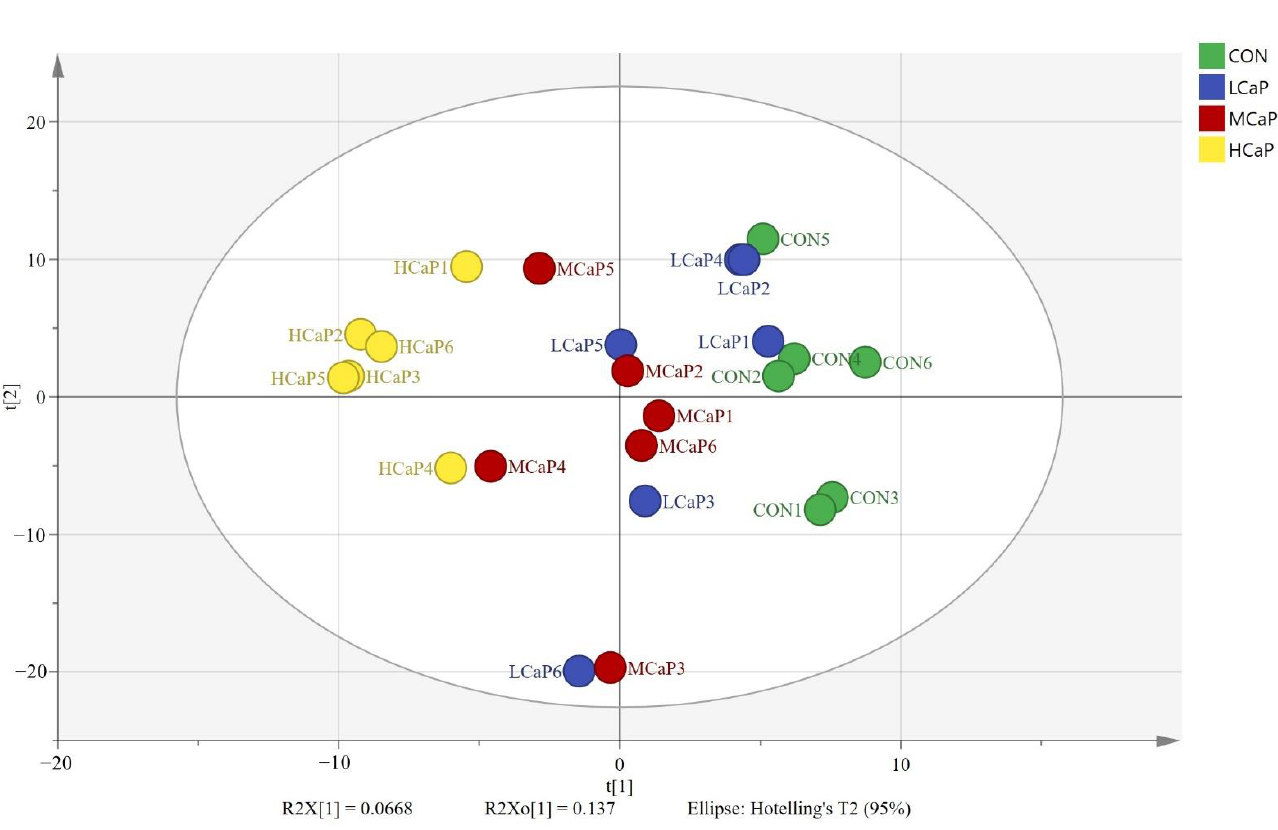
Figure 2. Orthogonal projections to latent structures discriminant analysis (OPLS-DA) score plot for the milk samples collected from different feeding levels of calcium propionate in early-lactation dairy cows. CON: control group, without calcium propionate addition; LCaP: low calcium propionate, the calcium propionate addition level was 200 g/d per cow; MCaP: medium calcium propionate, the calcium propionate addition level was 350 g/d per cow; HCaP: high calcium propionate, the calcium propionate addition level was 500 g/d per cow.